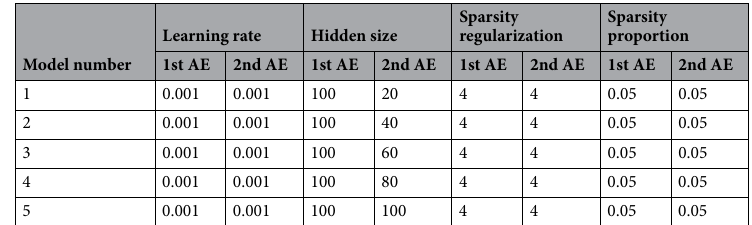
Table 3. Parameters for proposed deep stacked sparse autoencoder neural